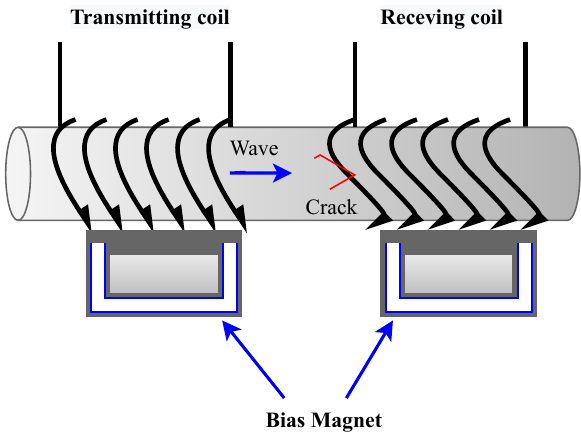
Figure 15. Principle of the magnetostrictive